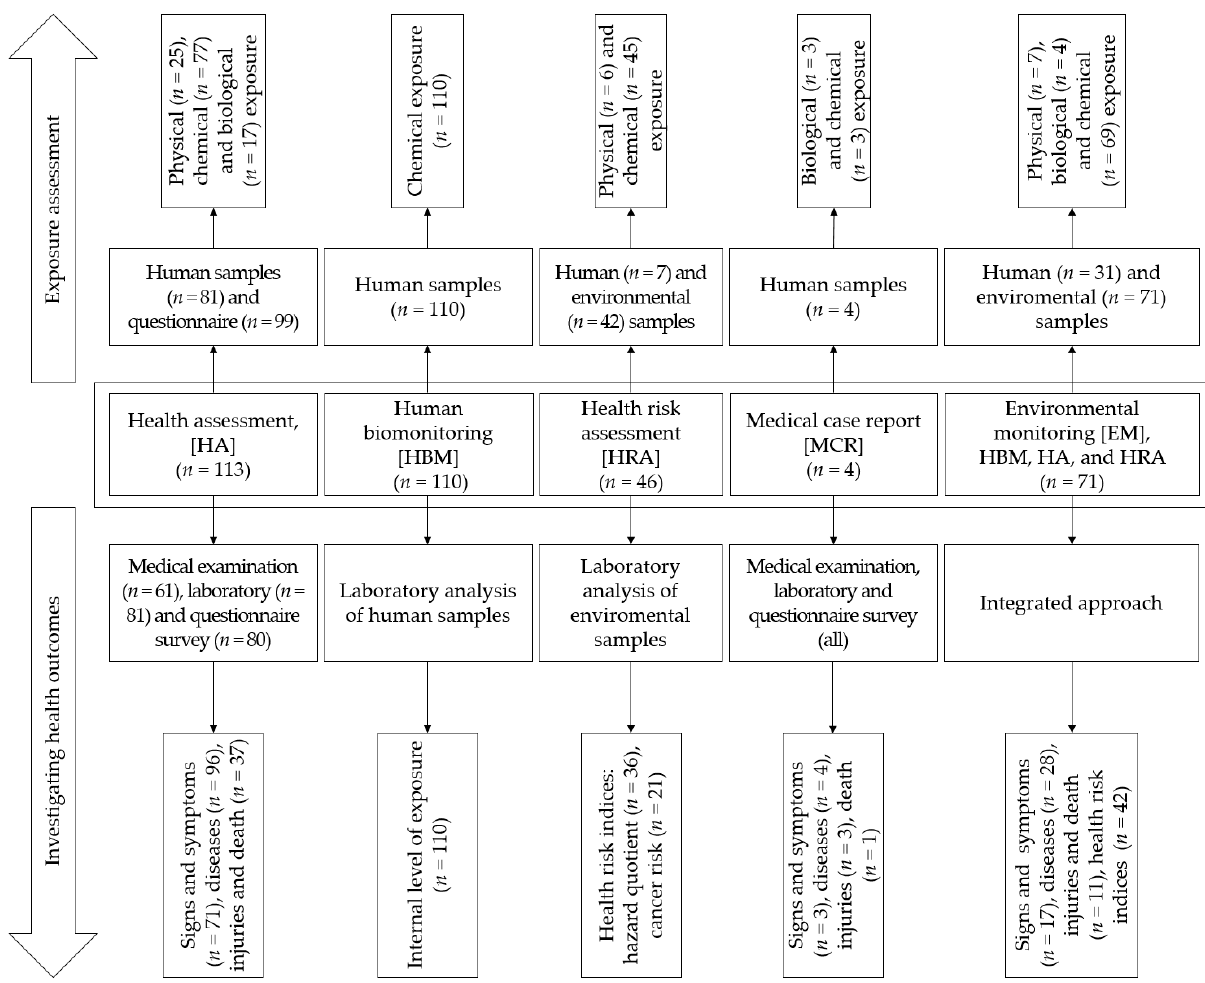
Figure 4. Overview of the main study type clusters, and a conceptual framework of exposure assessment and health outcome investigation strategies. Overlaps exist between different approaches; hence, frequency exceeds the total of 176 included studies.